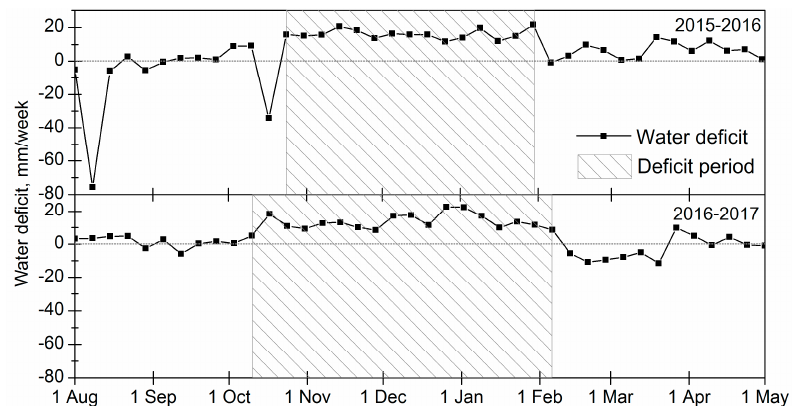
Figure 3. Weekly evolution of the water deficit estimated by the difference between farmer irrigation management and the modeled net irrigation water requirements (NIWR). A water deficit lower than 0 indicates over-irrigation and a water deficit greater than 0 indicates